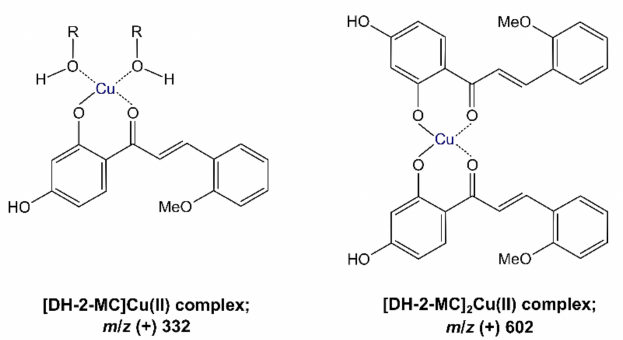
Figure 9. The proposed mono- and dimeric structures of DH-2-MC and Cu(II) complex. In the monomeric complex, R-OH molecules may appear as additional ligands (R = H, Me, or Et, related to the synthesis and analysis conditions), which do not interfere in its MS analysis.